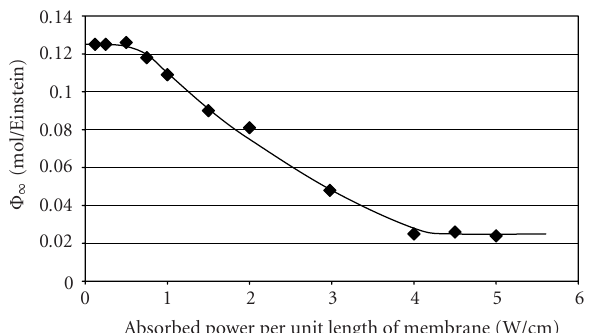
Figure 2: Quantum e ffi ciencies Φ ∞ (mol/Einstein), extrapolated by (1) (see Section 2), at “infinite” concentration of substrate for methane in aqueous solution as a function of absorbed power per unit length of irradiated photocatalytic membrane expressed as Wcm − 1 .